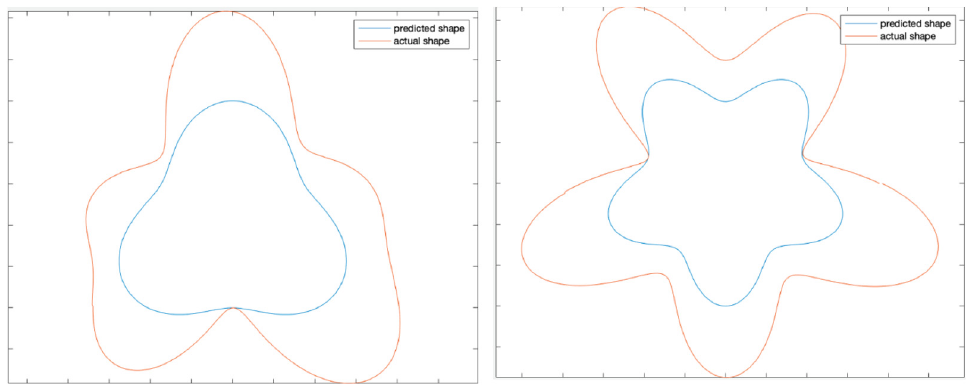
Figure 12. Deformed shape 3 orders (X-resonance) and symmetrical shape 5 orders (X- and Y-resonance).